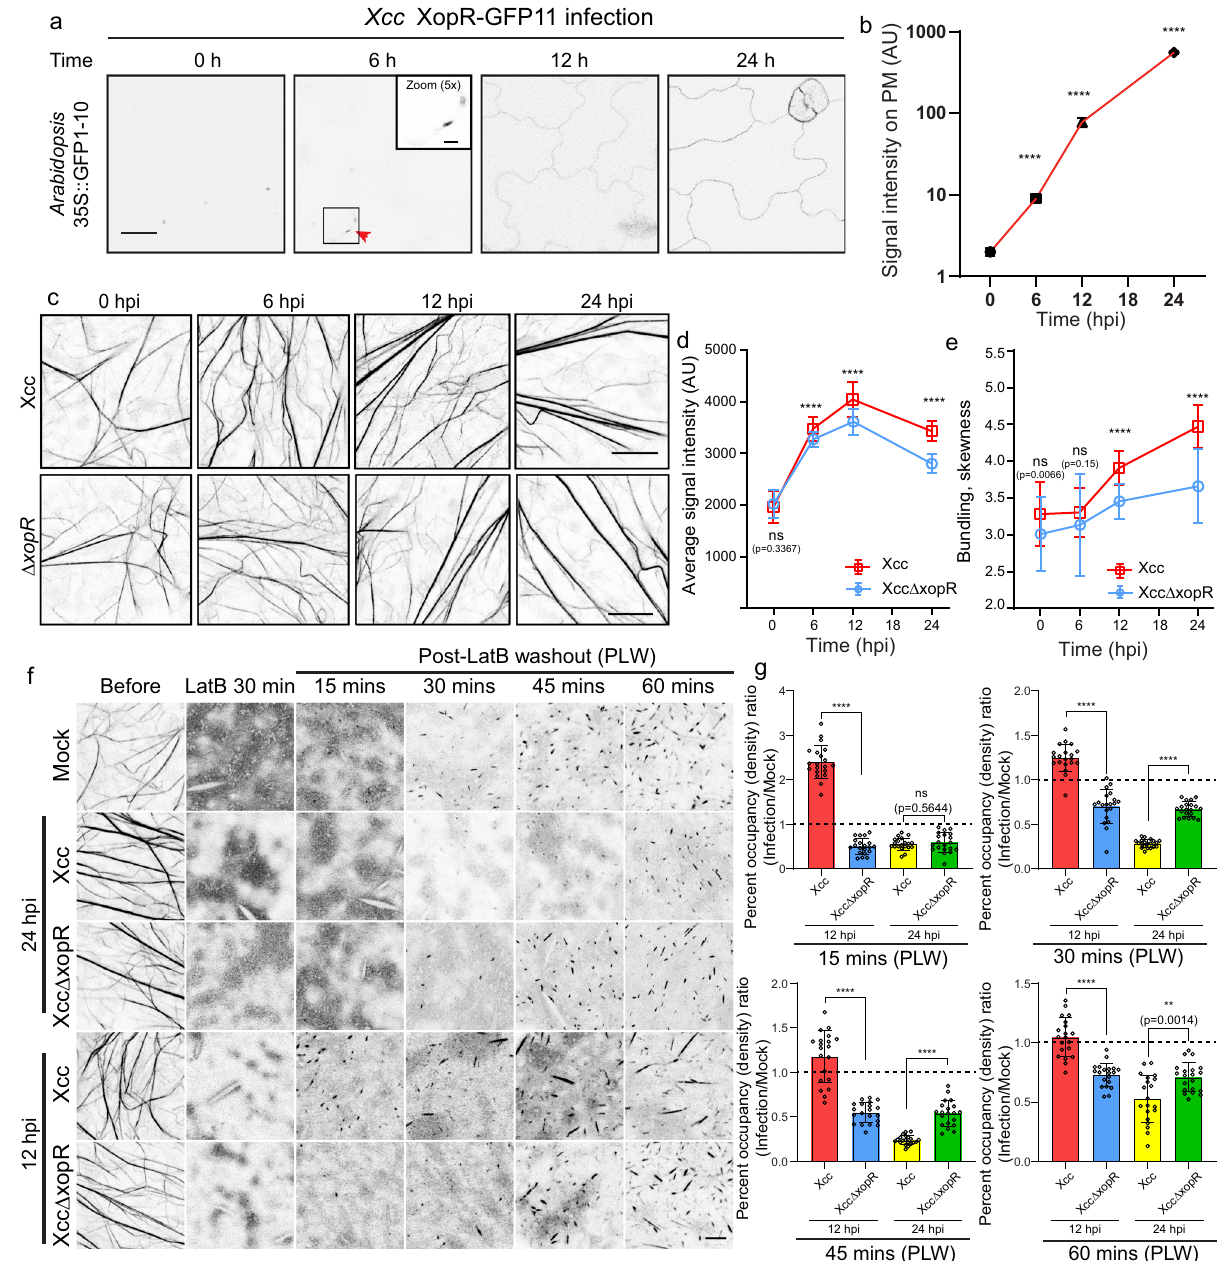
Fig. 1 T3E XopR remodels the Arabidopsis actin cytoskeleton during Xcc infection. a , b Representative images of XopR-GFP (self-complementing) at different time points and quanti fi cation ( n = 20) after infection. The red arrow indicates weak signal accumulation on the plasma membrane. Data were presented as mean values± SD. c – e Representative images of Lifeact-Venus in epidermal cells of Arabidopsis cotyledons and image quanti fi cation. Seven- day-old seedlings were dip-inoculated with WT Xcc and Xcc Δ xopR . Images were taken at 0, 6, 12, and 24 h postinoculation (hpi). The average signal intensity per image and skewness of Lifeact-Venus were measured ( n = 50 images from ten individual seedlings). Data were presented as mean values ± SD. f , g Representative images and actin density analysis of Lifeact-venus in LatB washout assay. Seven-day-old seedlings were fl ood-inoculated with Xcc or Xcc Δ XopR at the indicated hpi, then subjected to 5 μ M LatB treatment for 30 min before washout and image acquisition at the indicated time points of post- LatB washout (PLW). Percent occupancy was measured in the LatB washout assay ( g , n = 20, from fi ve seedlings). Data were presented as mean values ± SD. Two-tailed Student ’ s t -test was performed assuming equal variance. Ns no signi fi cant difference, * p < 0.05, ** p < 0.01, *** p < 0.001, **** p < 0.0001. AU arbitrary unit. Scale bar: 20 μ m in a 5 μ m in zoomed-in image of a , 10 μ m in c , and 5 μ m in f